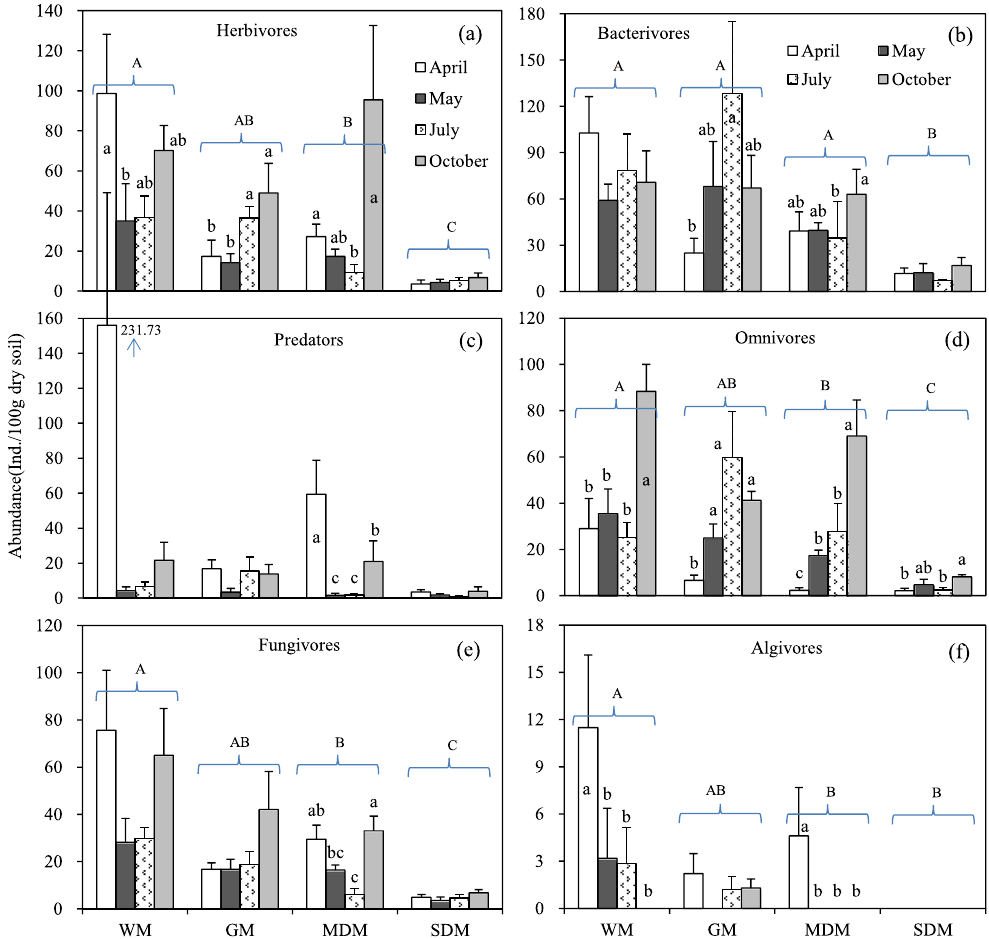
Figure 5. Spatio-temporal variations of the abundances of the six trophic groups across the four habitats (mean + SE). Lower-case letters indicate temporal differences within habitats at the P < 0.05